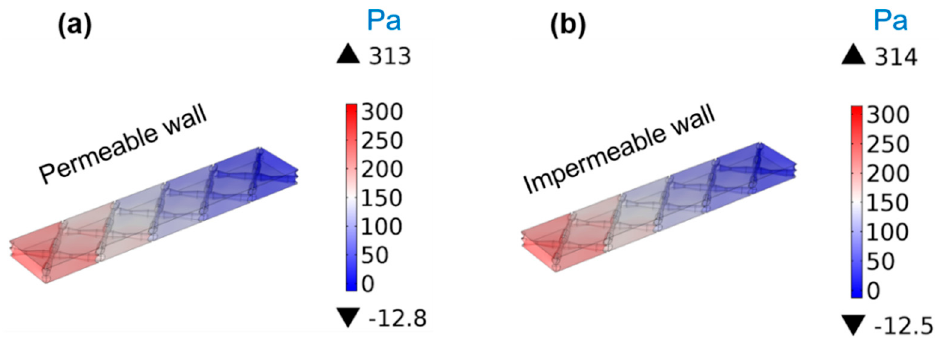
Figure 6. The pressure magnitude distributions with an inlet average velocity magnitude of 0.15 m s − 1 using ( a ) the permeable wall model and ( b ) the impermeable wall model. Using the permeable and impermeable wall models, the calculated friction coefficient ( f ) and Sherwood number ( Sh ) are shown in Figures 7a–d and 7e–h, respectively, with the use of a commercial SWRO membrane (Case 1: L p = 1 L m − 2 h − 1 bar − 1 ) and HPMs (Case 2: L p = 3 L m − 2 h − 1 bar − 1 ; Case 3: L p = 5 L m − 2 h − 1 bar − 1 ); Case 4: L p = 10 L m − 2 h −